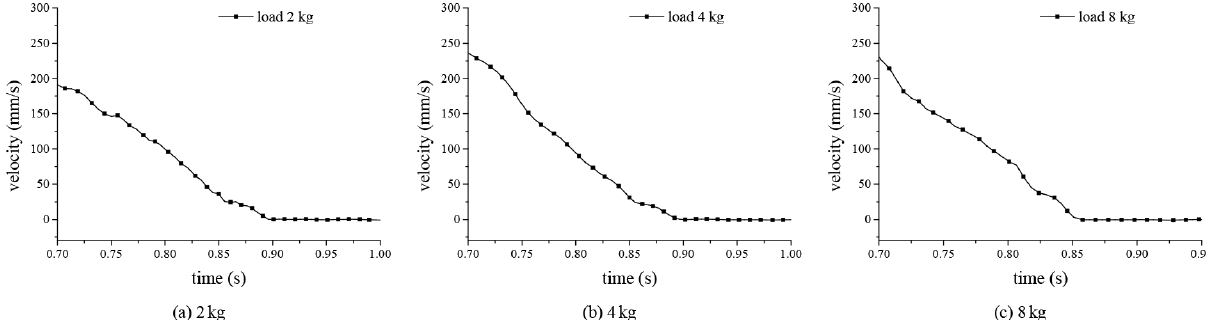
Figure 24. Positioning tests under different loads with the relay and run strategy.